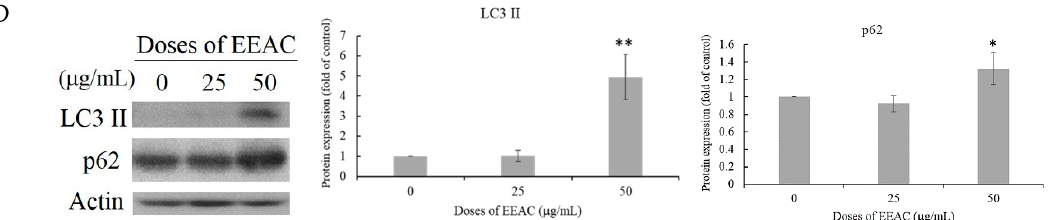
Figure 2. Effect of EEAC on cell cycle progression and autophagy induction. T47D cells were treated with EEAC (25 and 50 μ g/mL) for 48 h. ( A ) Determination of cell cycle progression using flow cytometry and quantification was done by MultiCycle software. ( B ) Expression of G1 phase-related proteins cyclin E2, cyclin D3, and cyclin D1, CDK2, and CDK4 was determined by Western blot assay. ( C ) Expression of AKT/FOXO1 signaling pathway proteins was determined by Western blot assay. ( D ) Expression of autophagy-related proteins LC3 II and p62 was determined by Western blot assay. Actin was used as the loading control. All the results are presented as mean ± SD of at least three experiments, * p < 0.05; ** p < 0.01; *** p < 0.001.